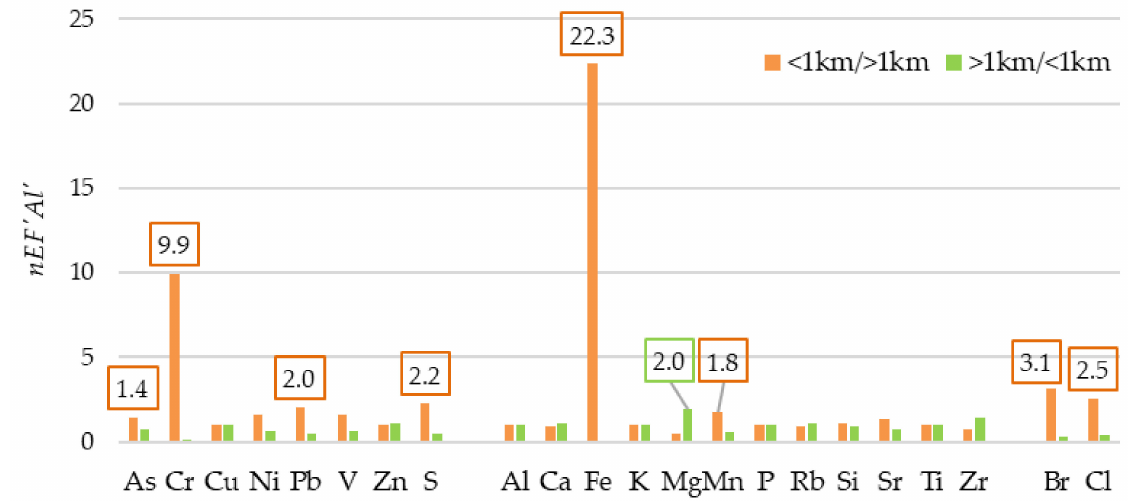
Figure 13. Ratios of median elemental nEF’Al’C or nEF’Al’N values in two areas. Explanation of the legend is in Figure